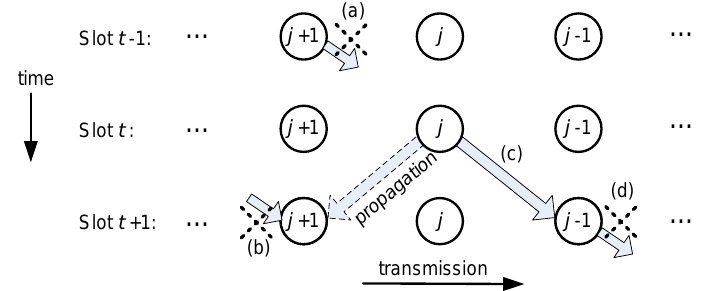
Figure 3. Collision-free constraints when node n transmits in time slot k . ( a ) In the previous slot t − 1, node j + 1 cannot transmit because node j will be busy transmitting in time slot t and will not receive the data. ( b ) Node j + 1 is not allowed to receive in time slot t + 1 to avoid the collision between the wave coming from node j and the expected wave from node j + 2. ( c ) Node j − 1 must be receiving the wave from node j in time slot t + 1, so that it cannot transmit in that time slot ( d ).